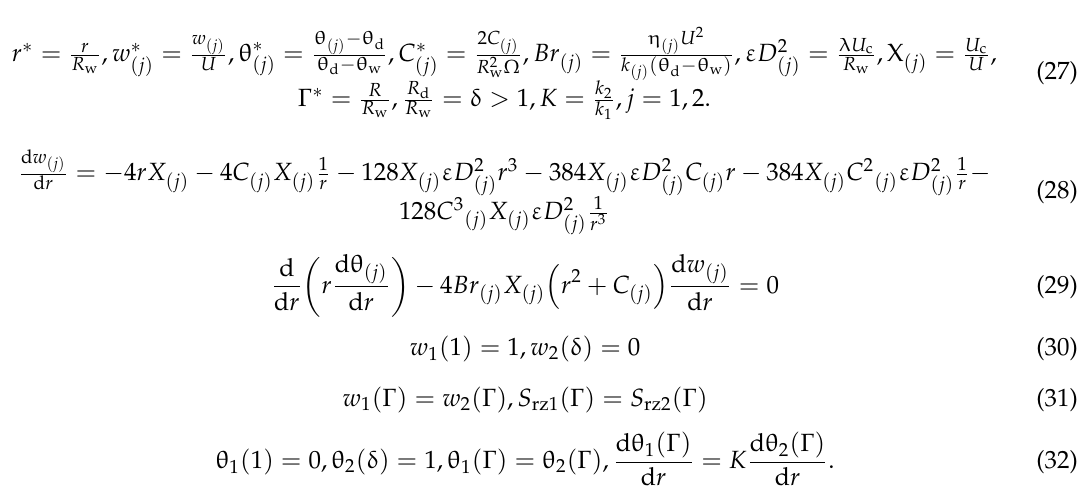
Figure 3. Comparison of analytical and numerical solutions when ε𝐷 (cid:2869)(cid:2870) = 5 , ε𝐷 (cid:2870)(cid:2870) = 10 , 𝑋 (cid:2869) = 0.5, 1.0, δ = 2 .